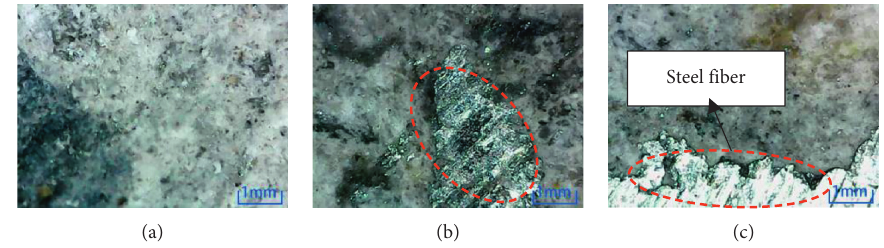
Figure 23: Microscopic observation of water immersion specimen at position 2. (a) 0%. (b) 1%. (c)